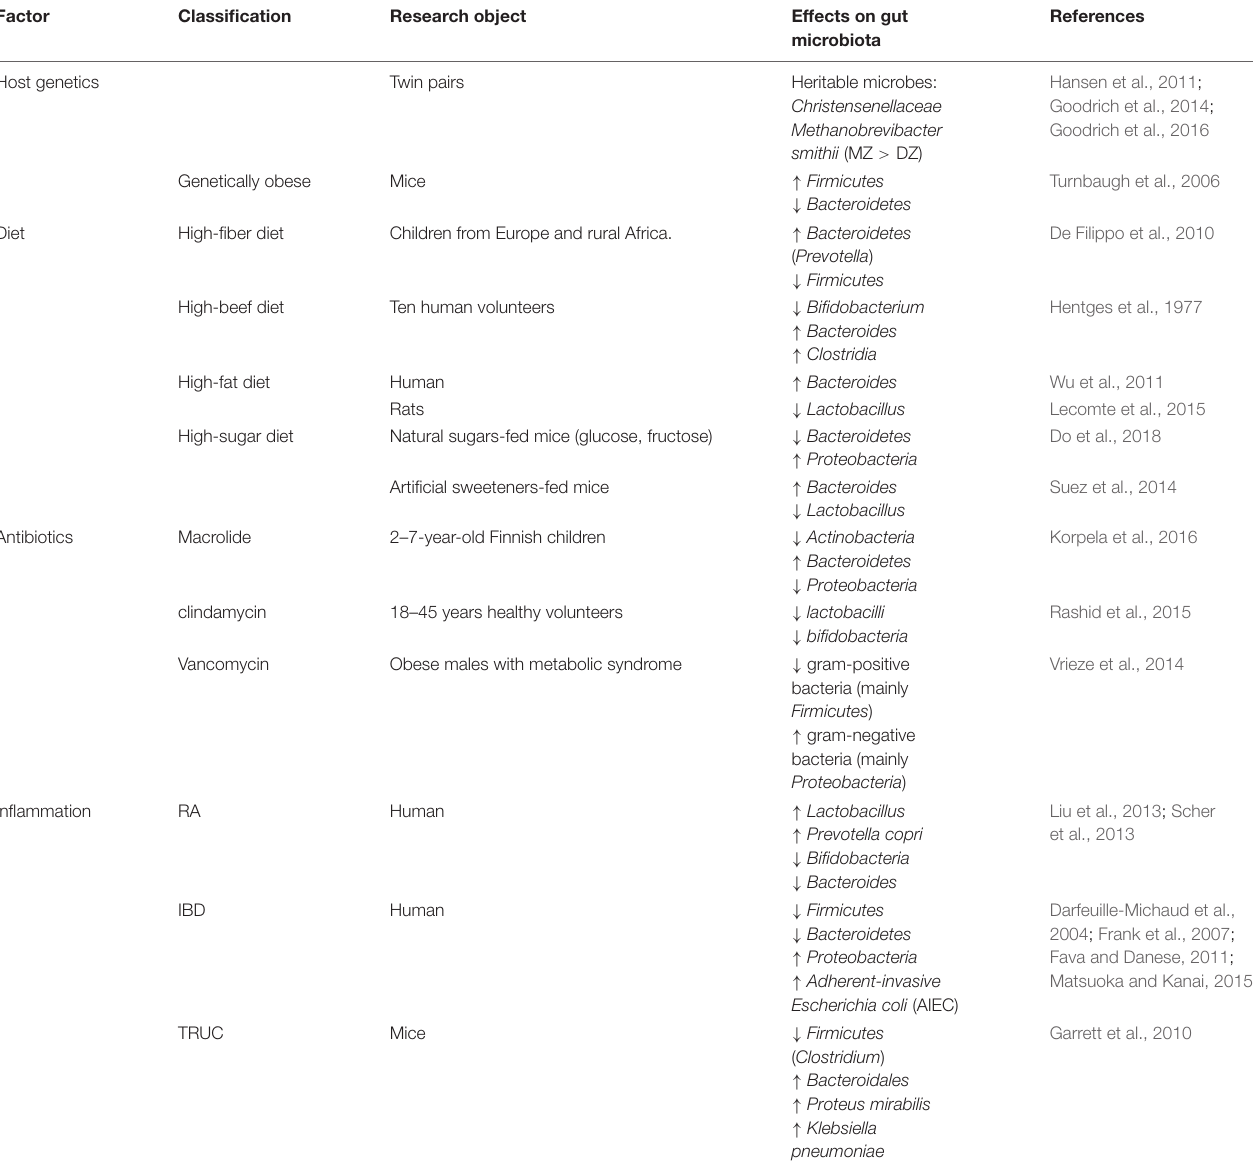
TABLE 1 | Factors that influence composition of gut